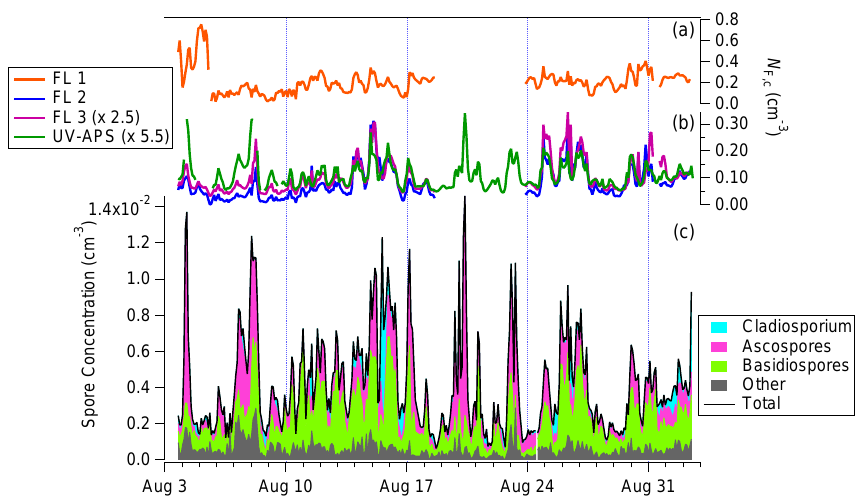
Figure 5. Temporal trends observed for coarse fluorescent particles (a–b) and spores sampled by Sporewatch (c) . WIBS FL1 N F , c plotted alone (a) ; WIBS FL2, FL3, and UV-APS N F , c traces plotted together (b) . Scaler values applied to FL3 and UV-APS traces are shown in the